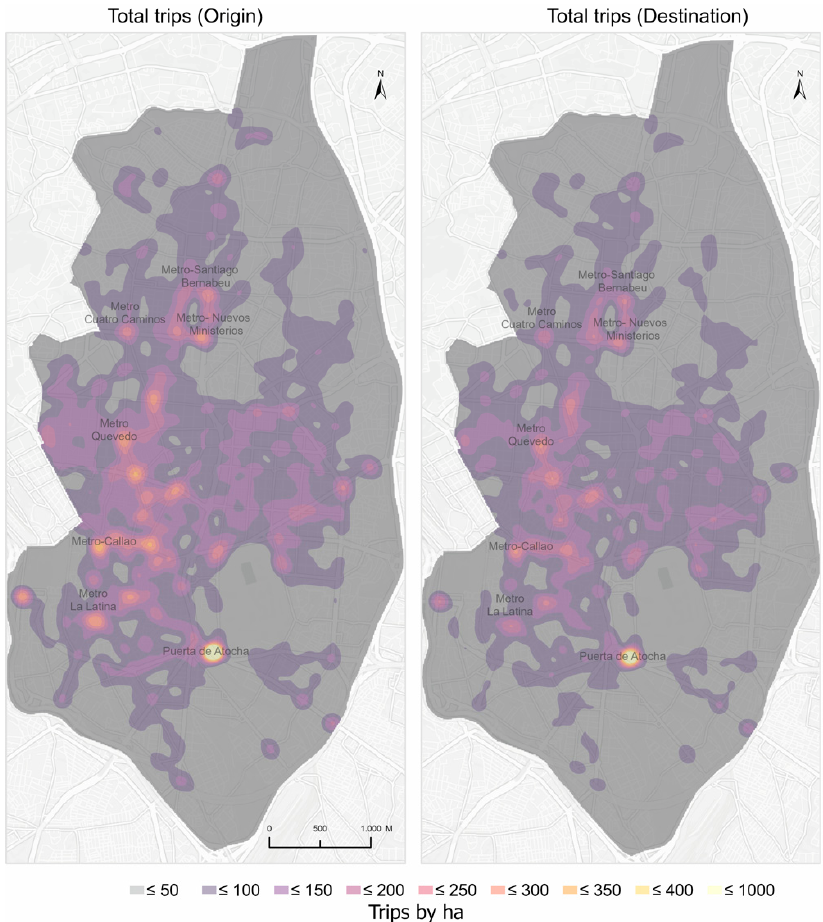
Figure 4. Density of trips per hectare by origin and destination. Table 1. Descriptive statistics of the density of origins and destinations per hectare.